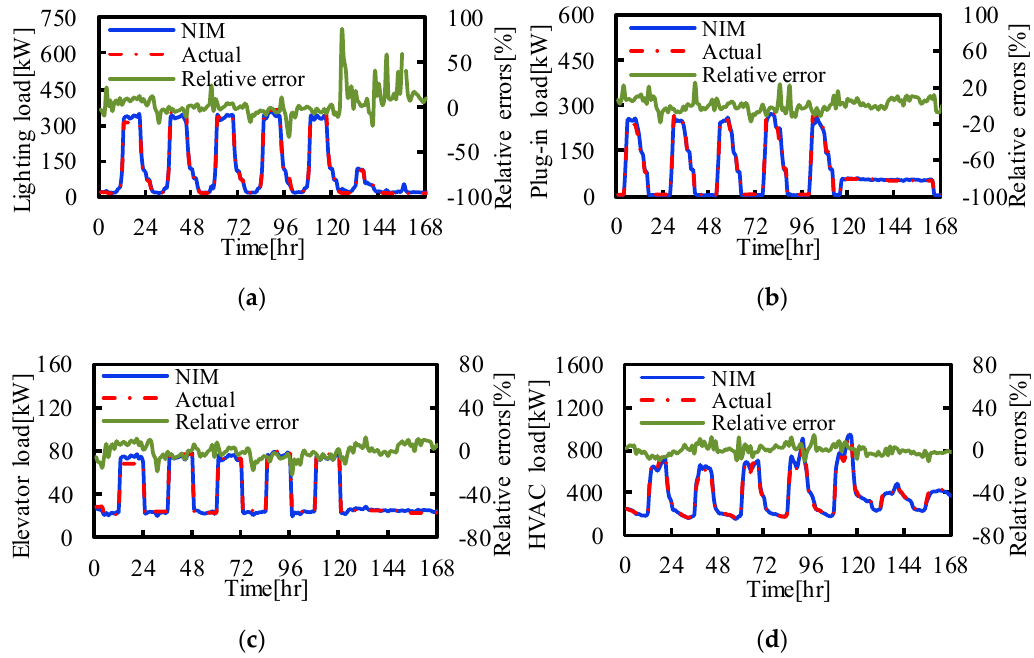
Figure 8. Testing results of the NIM model based on Approach II in a typical week: ( a ) the comparison results of lighting system load; ( b ) the comparison results of plug-in system load; ( c ) the comparison results of elevator system load; ( d ) the comparison results of HVAC system load.